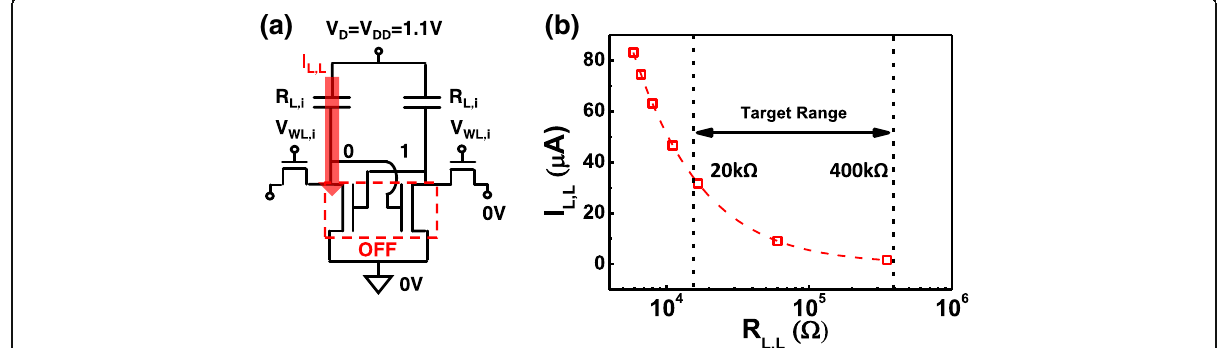
Fig. 7 a 4T2R SRAM cell in the hold condition. b As expected, loading resistance level, I L,L during hold can be lowered effectively by choosing a higher R